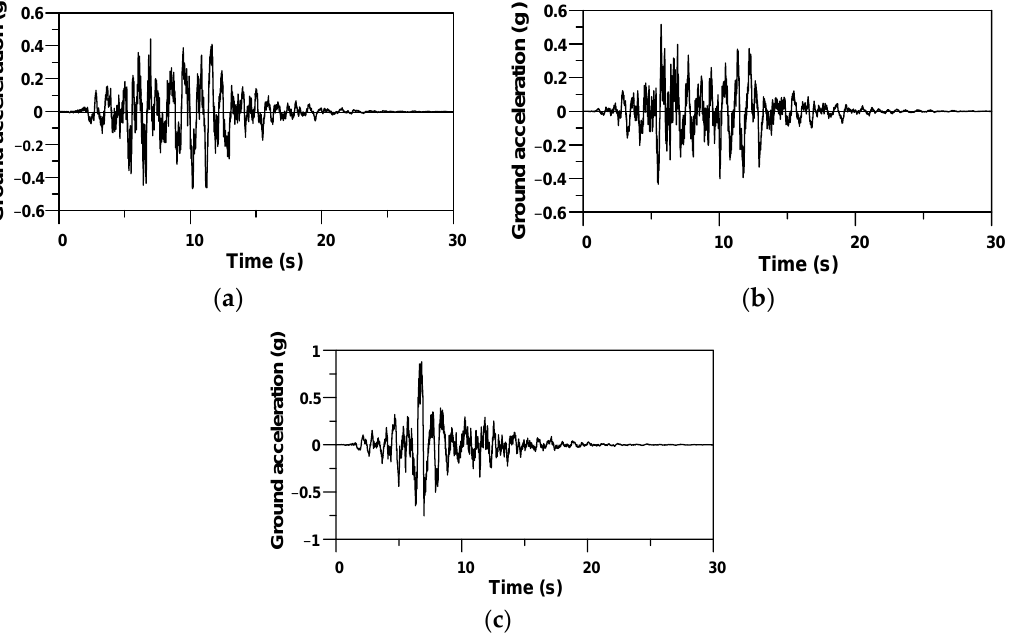
Figure 7. Time histories of artificial ground acceleration. ( a ) Earthquake for training. ( b ) Earthquake for verification1 (EV1). ( c ) Earthquake for verification2 (EV2).